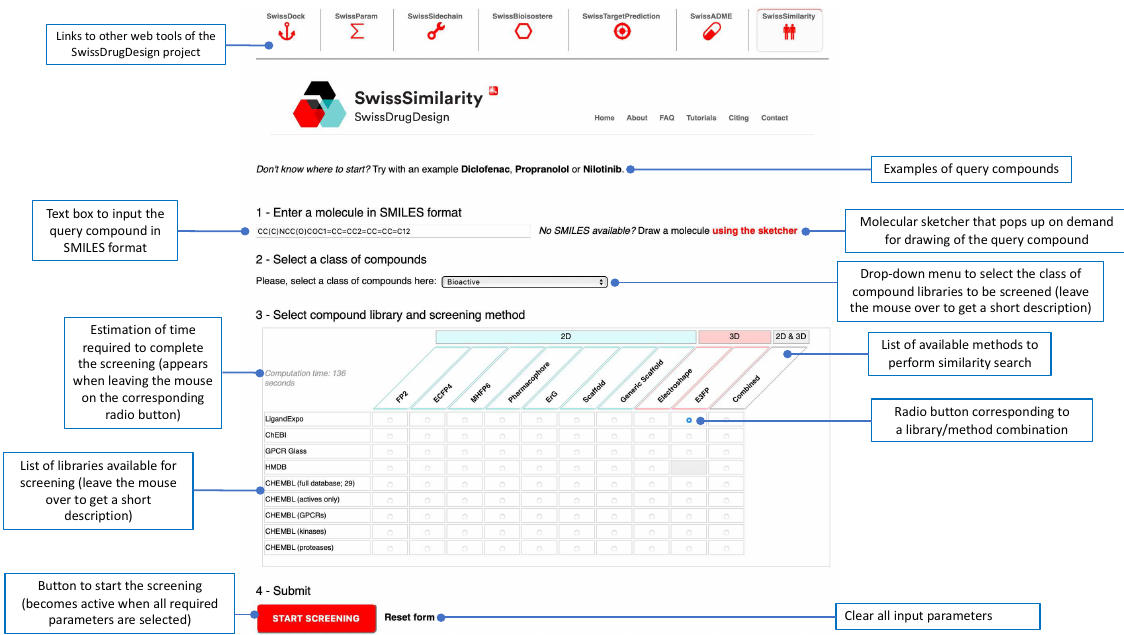
Figure 2. Submission page to set up, parameterize, and launch virtual screening.